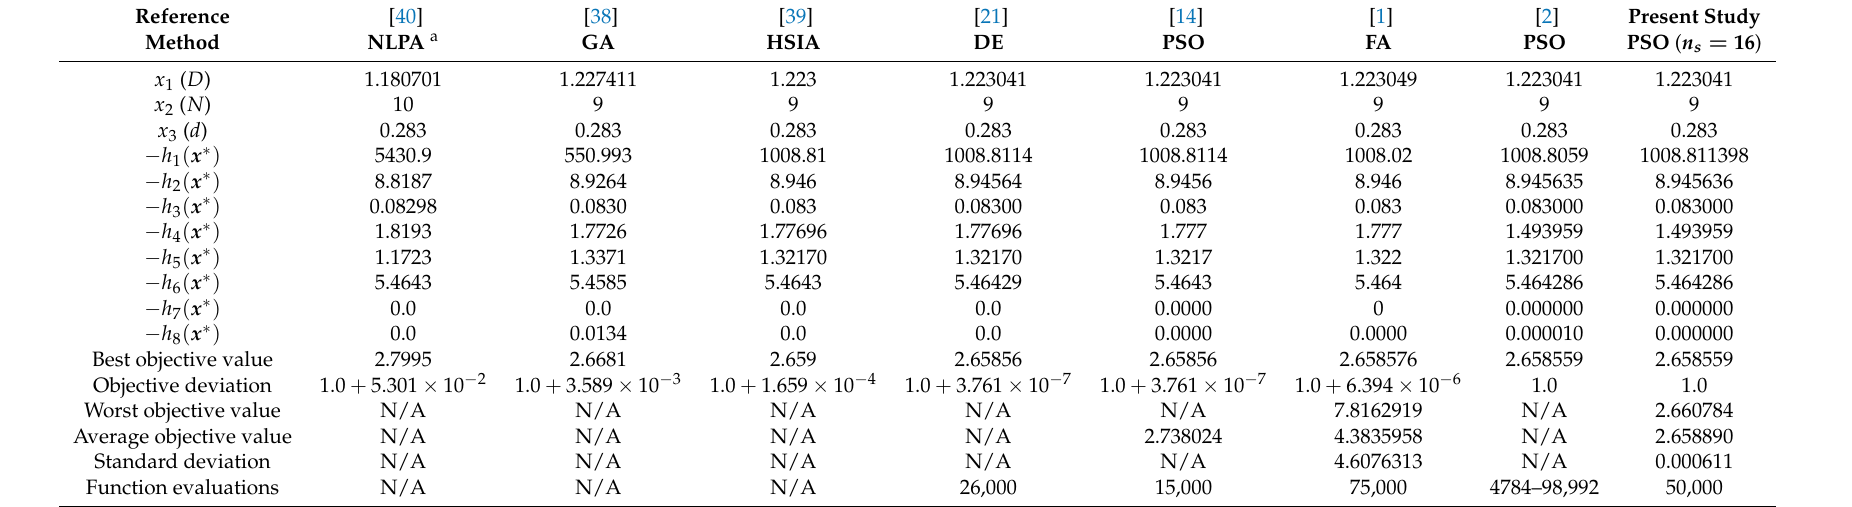
Table 6. Optimization results of the helical compression spring design